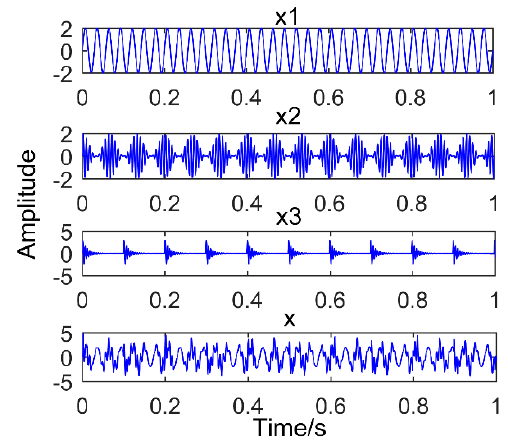
Figure 5. Simulated signal, x1: sinusoidal signal; x2: Modulation signal; x3: periodic impact signal; and x: Synthetic signal.